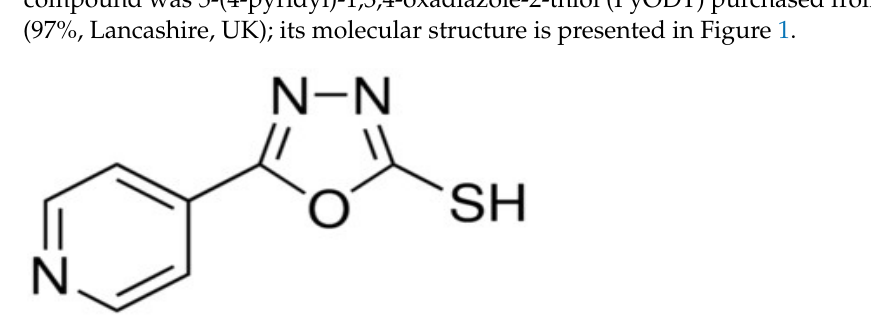
Figure 1. Molecular structure of 5-(4-pyridyl)-1,3,4-oxadiazole-2-thiol. The inhibitor-containing electrolytes were prepared by dissolving appropriate weighted amounts of PyODT in a mixture of 1.0 M HCl solution and ethanol (90:10, v / v ). The PyODT concentration in the test solution was in the range of 0.1 to 10